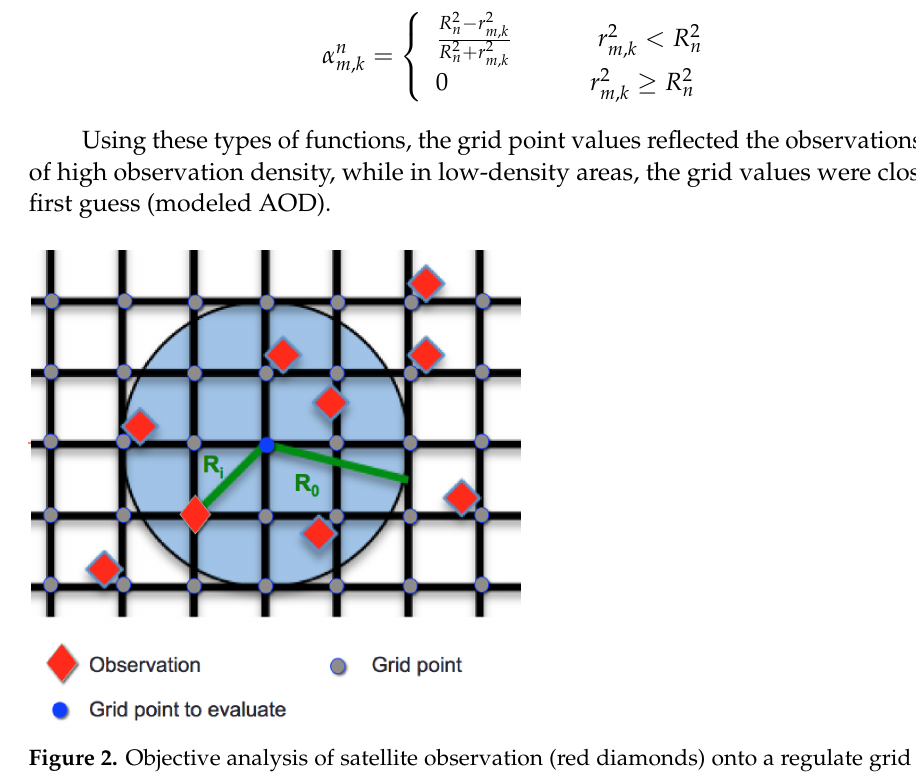
Figure 2. Objective analysis of satellite observation (red diamonds) onto a regulate grid shown in black using a circular influence (blue circle) as used in the Creesman scheme. R 0 is the radius of influence at the first iteration, and R i is the distance between the observation point and the grid